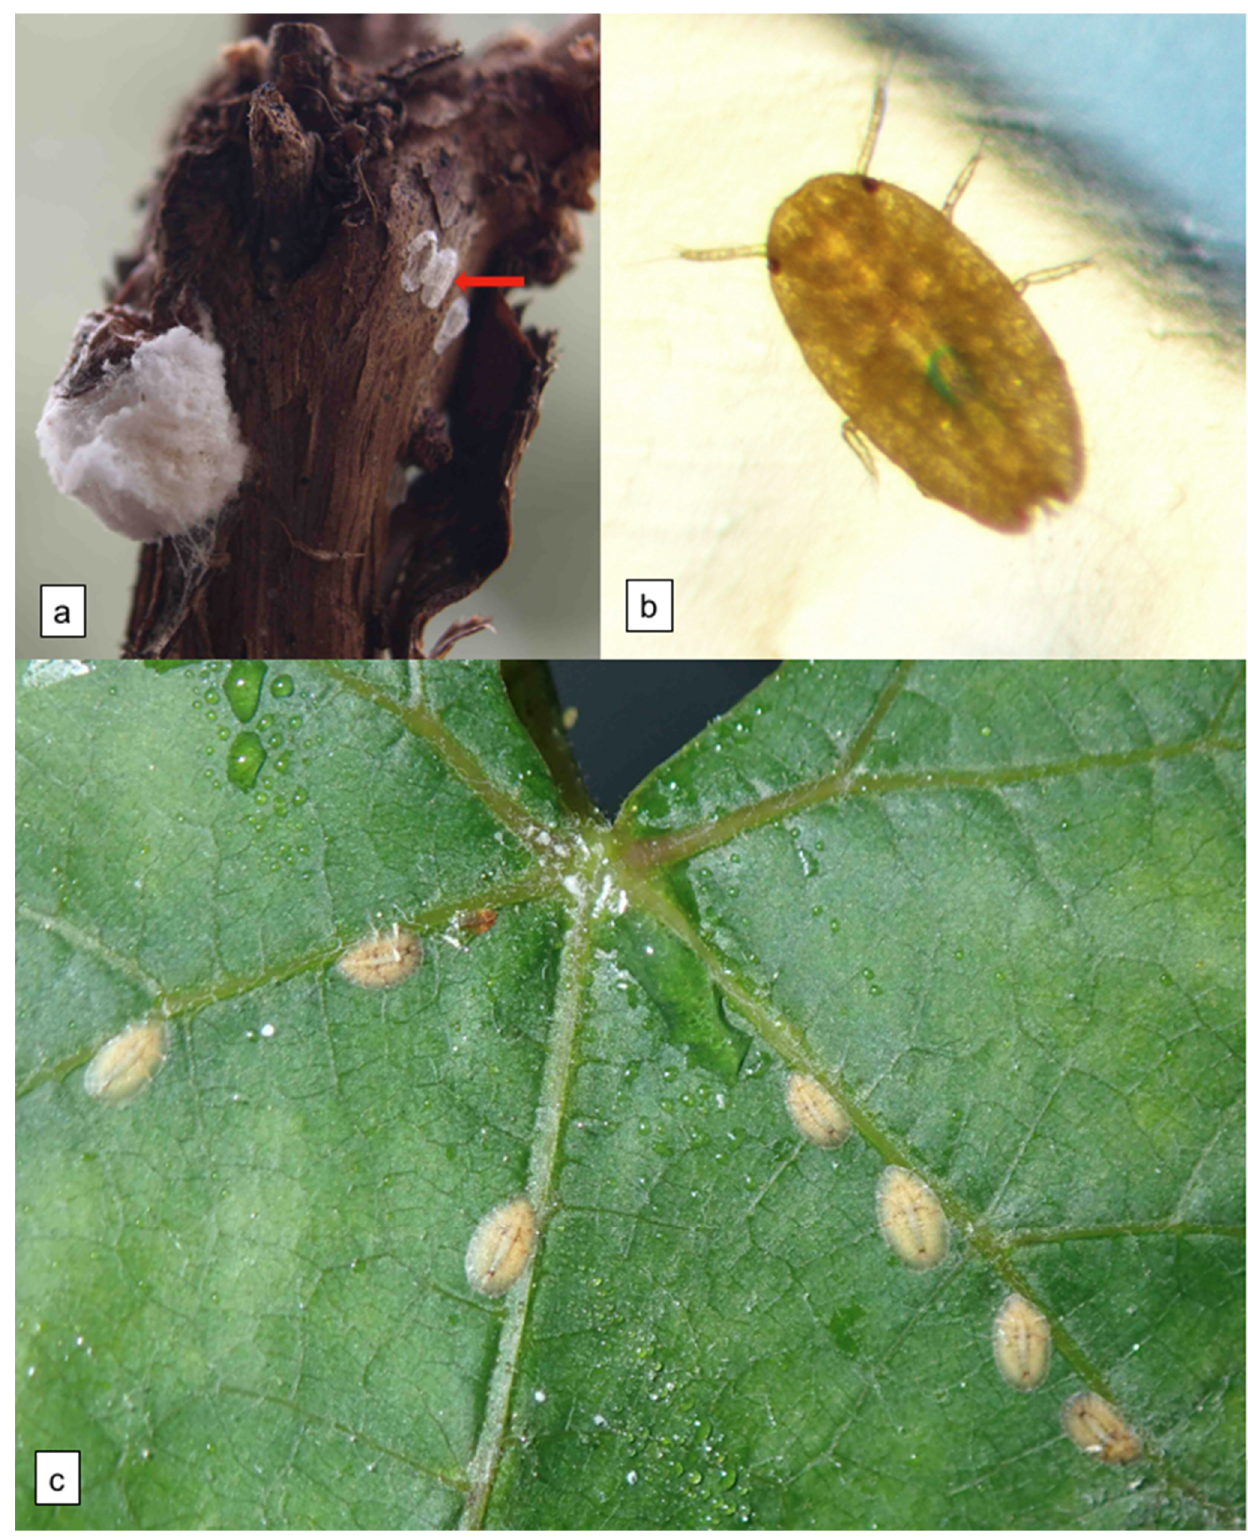
Figure 1. ( a ) Pulvinaria vitis specimens on a grapevine. Left: female with ovisac. Red arrow: three empty plate-like tests or “puparia” of males. ( b ) Second instar nymphs (L2) of P. vitis on a grapevine leaf, with honeydew drops. ( c ) Crawlers of P. vitis fed across a Parafilm™ membrane stretched over a drop of purified virions added with methylene blue. Blue stain is visible in the gut of the